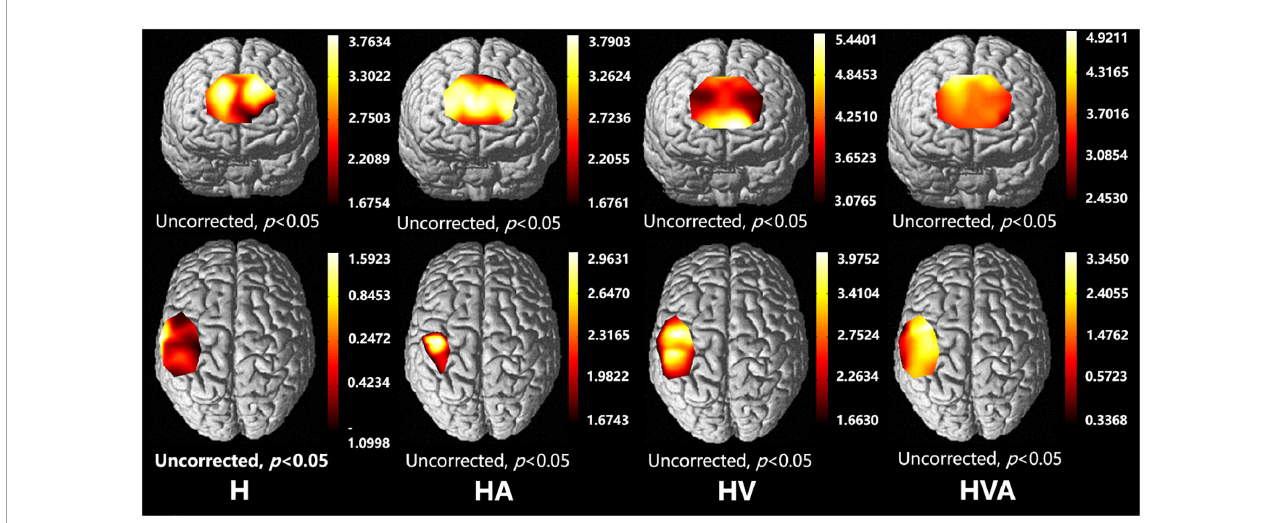
FIGURE6 Optical imaging of cortical activities (group analysis). The abbreviations in the figure represent haptic (H), haptic + auditory (HA), haptic + visual (HV), and haptic + visual + auditory (HVA).